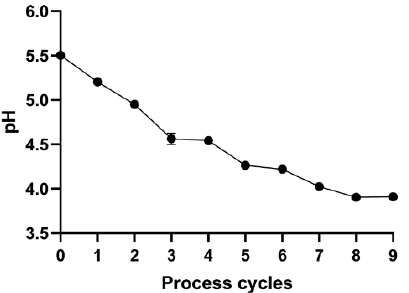
Figure 1. Changes in pH values for PR samples with different processing levels.